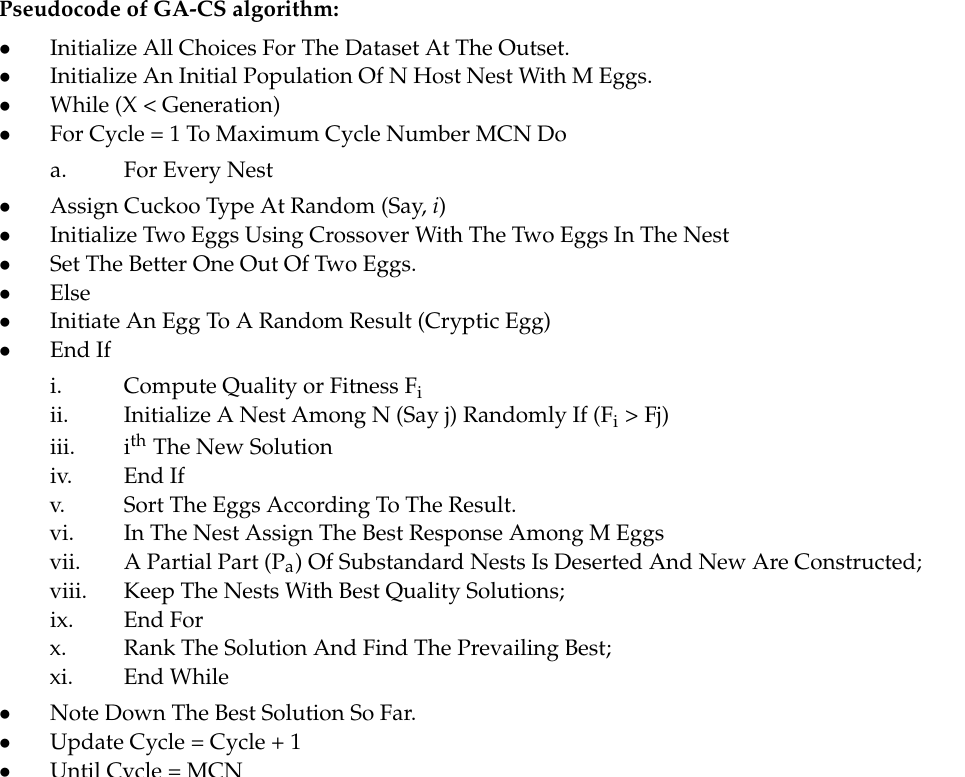
Algorithm 1. Proposed optimization algorithm